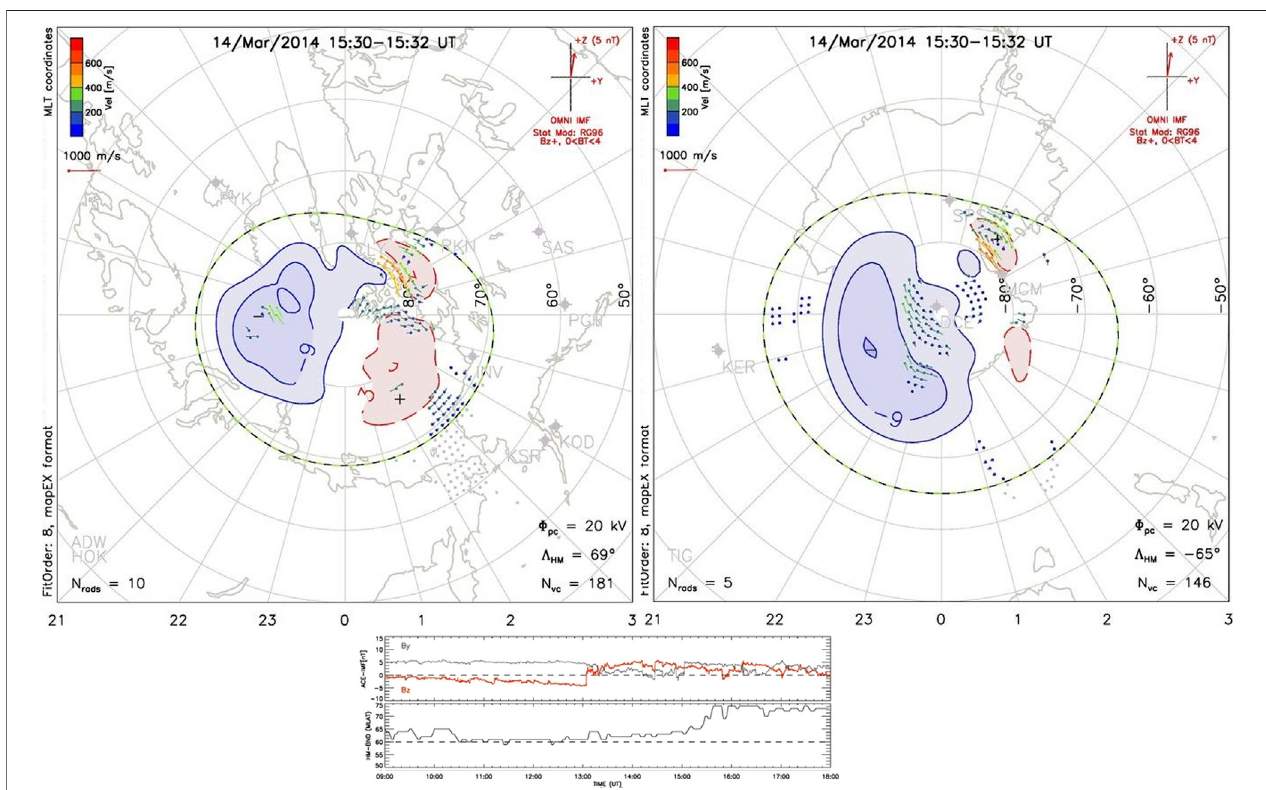
FIGURE5|Toppanels: ionosphericconvectionpatternmeasuredbySuperDARNintheNorthernhemisphere (leftpanel) andintheSouthernhemisphere (right panel) on March 14, 2014 at 15 h 30 UT. The x -axis gives the MLT. The green lines represent the Heppner-Maynard Boundary (HMB). The blue-red shades show the ionospheric potential. Bottom panel: Time evolution from 9h00 to 18h00 UT of the HMB boundary on 14 March 2014 estimated by SuperDARN in degrees of geomagnetic latitude at 0h00 MLT.